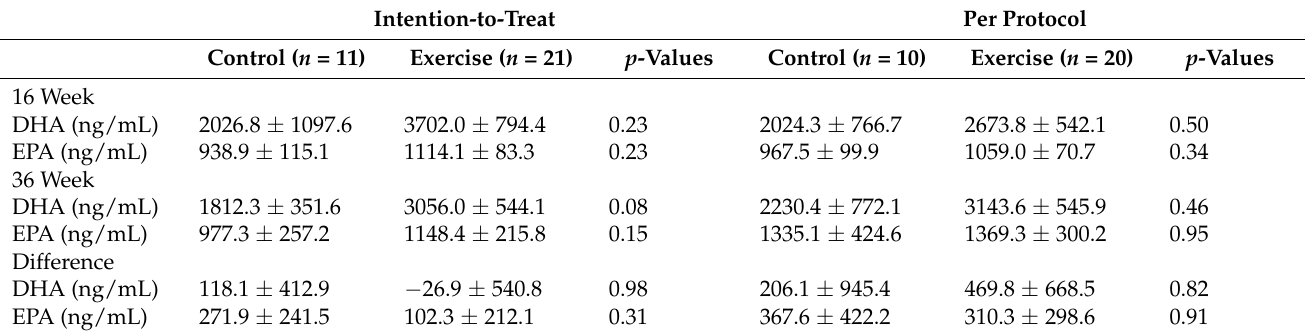
Table 2. Maternal DHA and EPA concentrations between aerobic exercise and non-exercising controls.